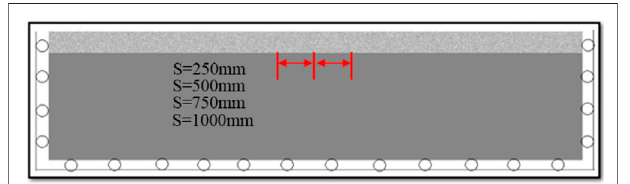
FIGURE 9 | Numerical model and boundary conditions.